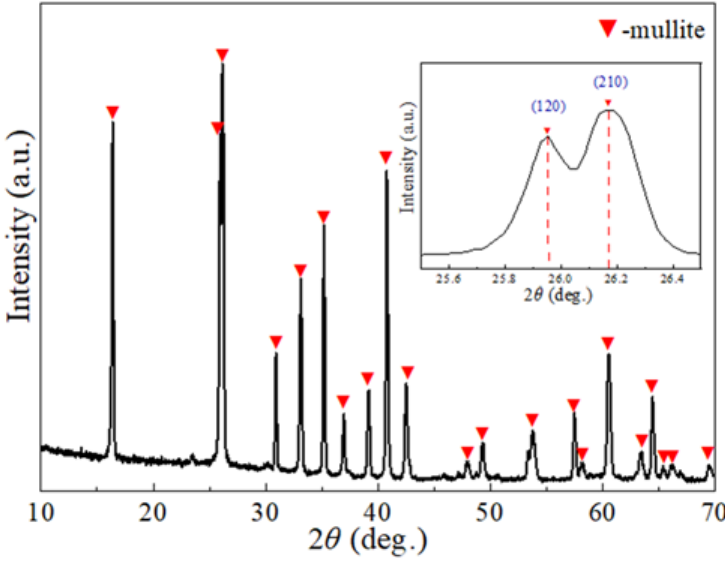
Figure 7. XRD pattern of flame spheroidized powders. Two diffraction peaks, at the angle range of 25.5–26.5 ◦ in the pattern of flame spheroidiza- tion mullite, were in accord with the XRD patterns of JCPDF 79-1456. The two diffraction peaks were indexed on an orthorhombic lattice as (120) and (210). According to the XRD patterns of (210) lattice, the Debye–Scherrer equation was used to calculate the grain size of flame spheroidization mullite powders. The average grain sizes of flame spheroidiza- tion mullite powders were approximate 48 nm. The bulk density was 1.21 g/cm 3 and flowability was 88.7 s/50 g (Table 5), which is superior to the characteristics of sintering feedstocks. The results indicated that the physical properties of flame spheroidization feedstocks, such as flowability and density, have been greatly improved. In the plasma spraying process, the heat is easily transmitted into the powder due to the high bulk density of the flame spheroidization mullite feedstocks. As a result, the flame spheroidization mullite feedstocks will be heated and melted to form a dense coating structure. Therefore, the flame spheroidization treated nanostructured mullite feedstocks are more suitable for plasma spraying to prepare high-quality EBCs. Table 5. Properties of flame spheroidized mullite